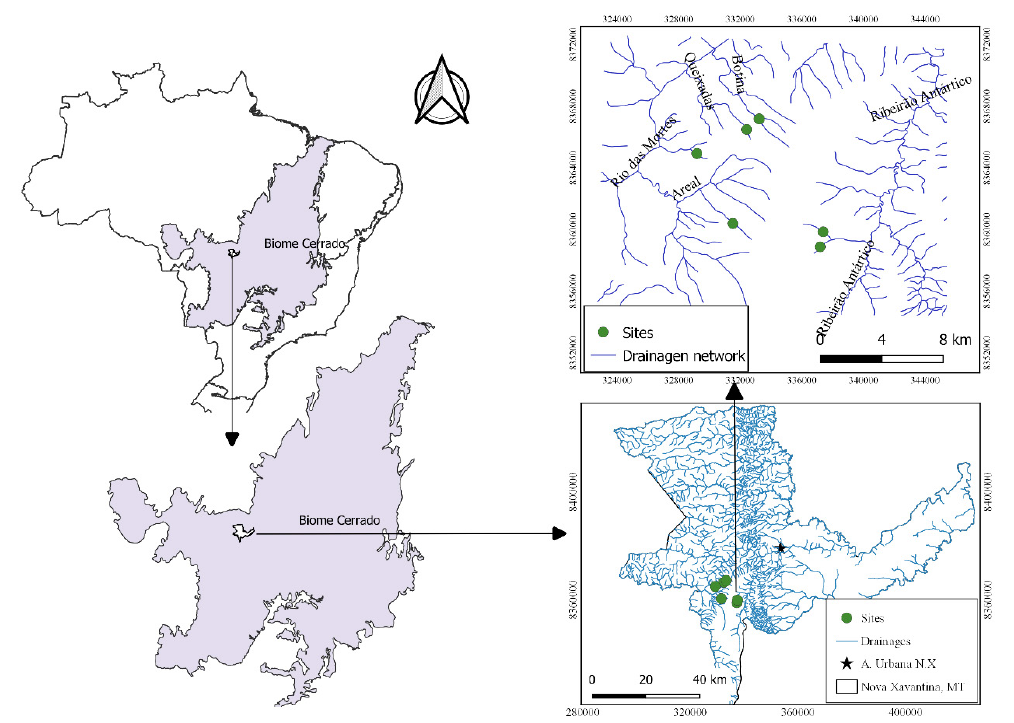
Fig 1. Location of the six study Veredas in the Cerrado–Amazon transition zone in the municipality of Nova Xavantina, in Mato Grosso state, central Brazil. The Veredas are identified according to the catchment in which they are located. Botina stream, and Chupador stream I and II, Areal stream, Coronel Vanique stream, and Queixada